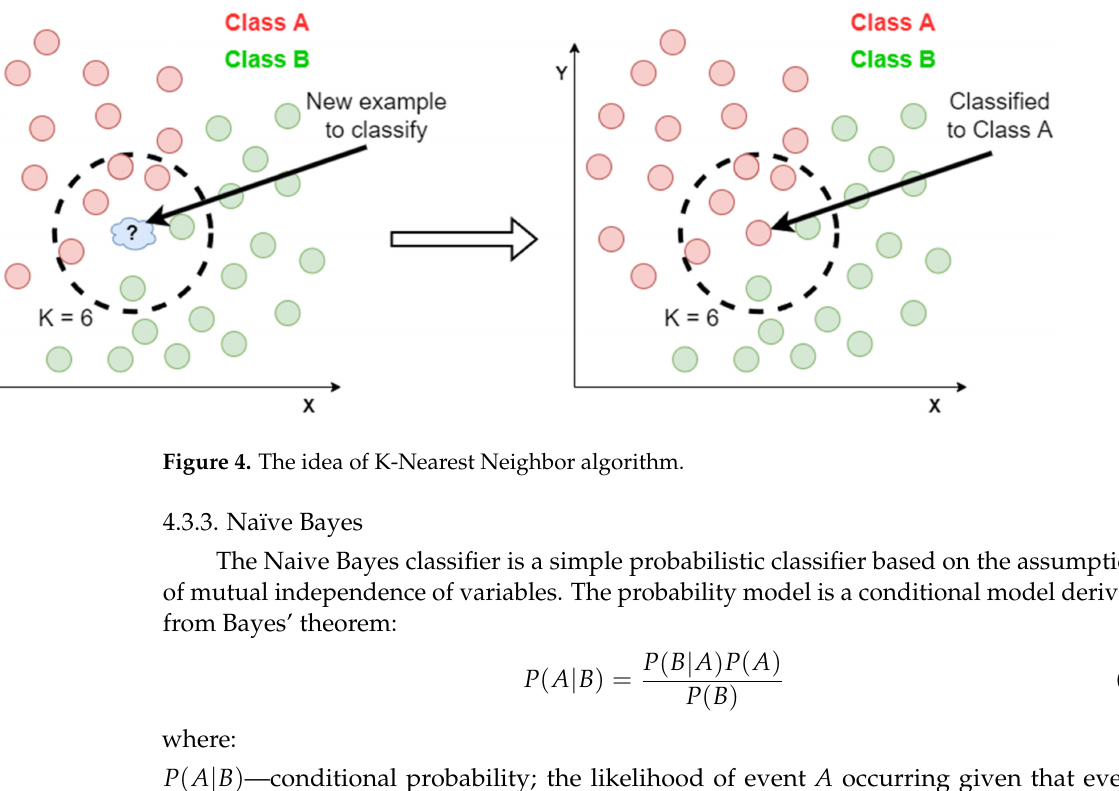
Figure 3. The idea of logistic regression separating variables into two classes.